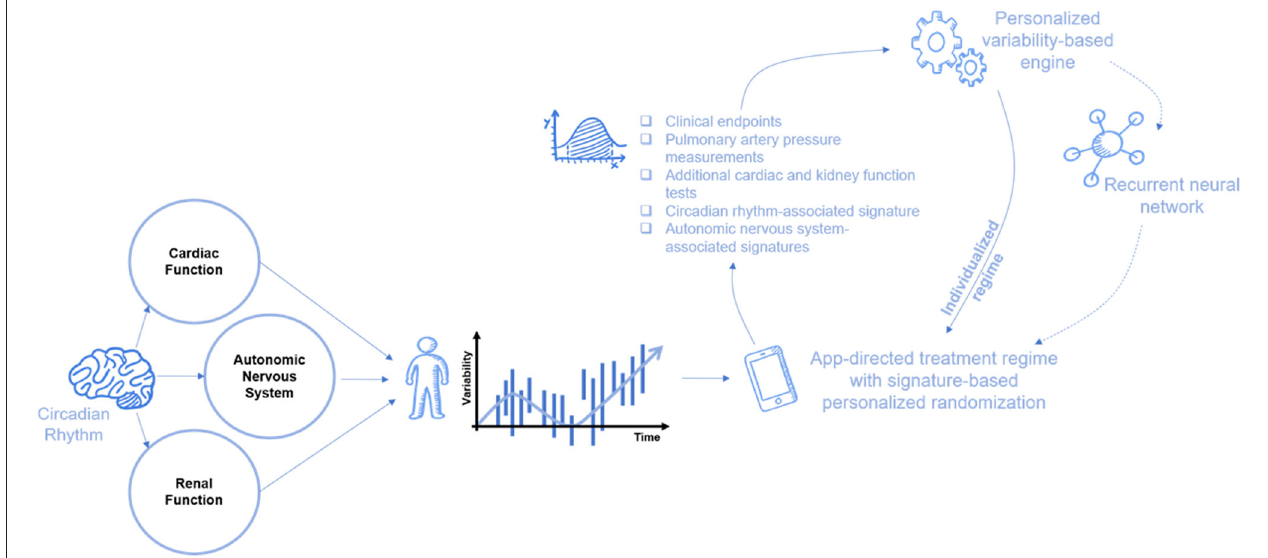
FIGURE 2 | A suggested scheme of the closed loop machine learning system for improving the response to diurectis in patients with HF. Inputs from various sensors are being incorporated in a dynamic manner for determining the timings of administration and dosages in a personalized approach. In a dynamic changing system with multiple alternating parameters, a continuously changing dosing regimen is generated based on the individualized-variability pattern that comprises data from the ANS (e.g., HRV), heart, and kidney. Cardiac, renal, and ANS, along with numerous other physiological and biological processes, exhibit intrinsic randomness. These variations in their activity are also contributed from the generalized circadian rhythm and from intrinsic biological rhythms. Randomized treatment administration within the preset limits augmented with personalized signature from the clinical status, echocardiographic, HRV, pulmonary artery pressure monitoring, biomarkers, and more can improve outcomes of the diuretic treatment. In addition, randomization might prevent renal adaptivity involved in the development of diuretic resistance. ANS, autonomic nervous system; HRV, heart rate